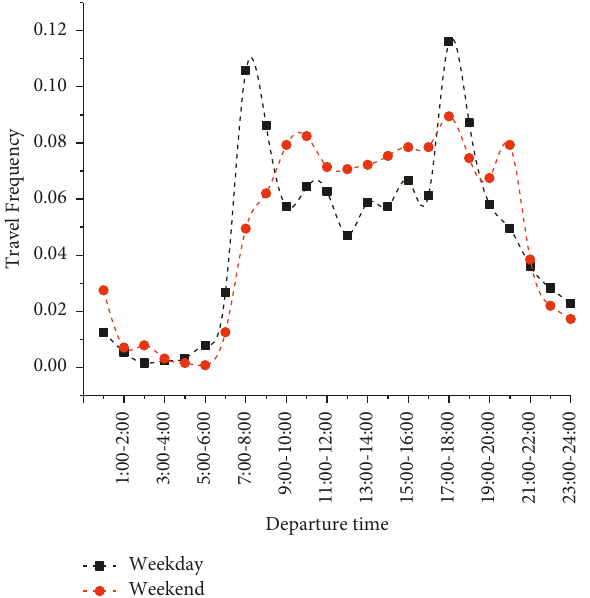
Figure 5: Travel frequency distribution of sampled residents in Chongqing.